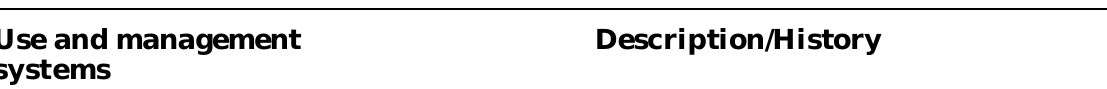
Table 1. Characteristics of a Rhodic Kandiudox under different use systems and periods of pig slurry and poultry litter